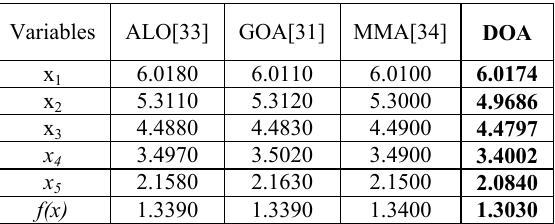
Table 2. Comparison of results for the cantilever beam